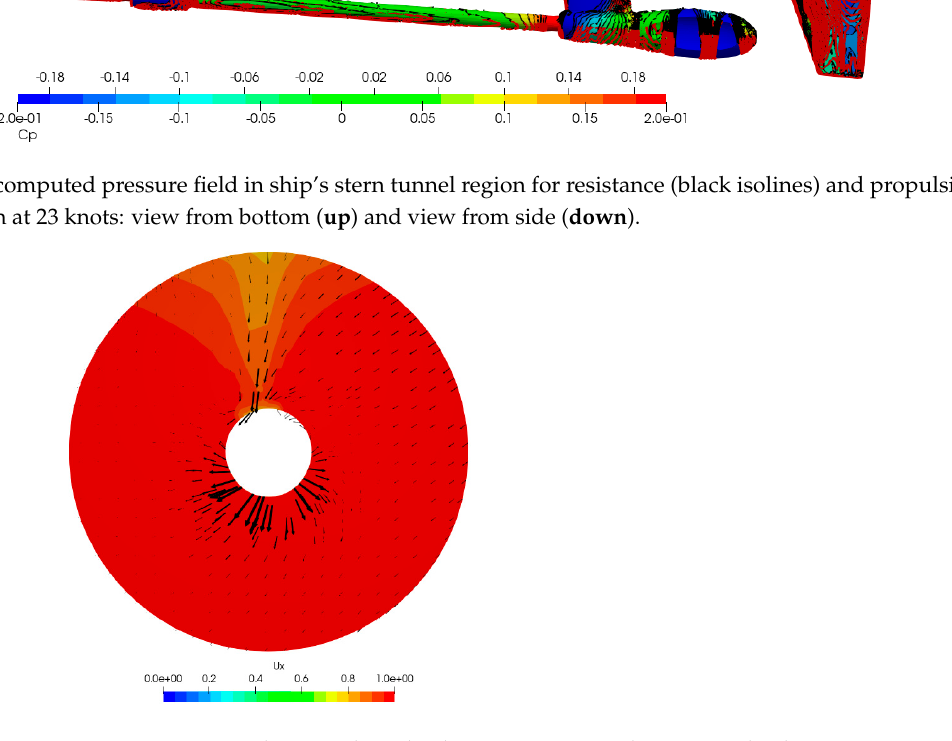
Figure 15. Computed nominal axial velocity contours and transversal velocity vectors at the (port side) propeller plane for ship speed at 23 knots (view from behind) .